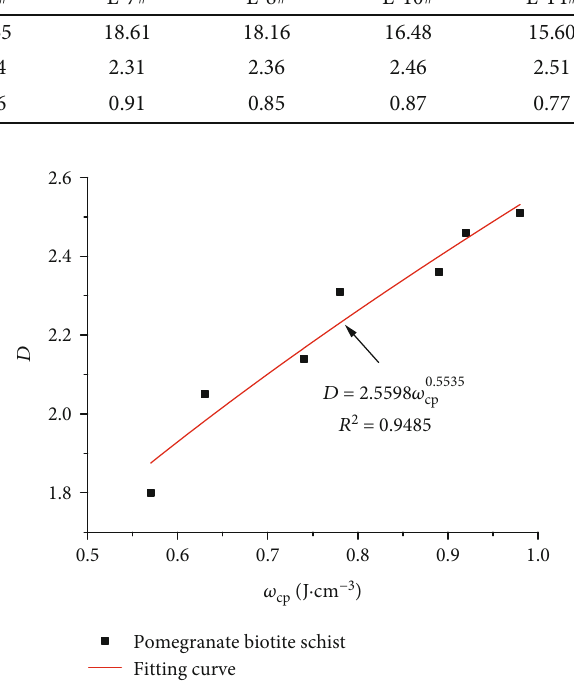
Figure 9: Fractal dimension of pomegranate biotite schist versus crushing energy density.